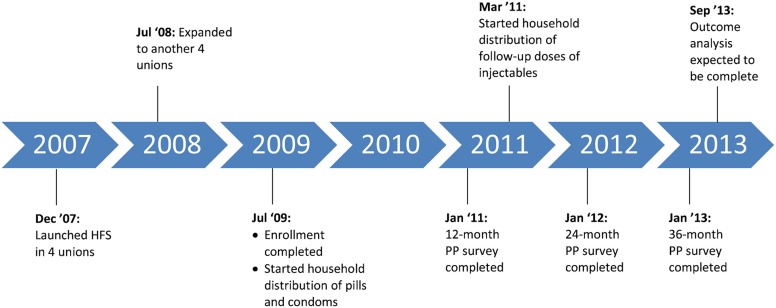
Timeline: Implementation of Healthy Fertility StudyAbbreviations: HFS, Healthy Fertility Study; PP, postpartum.